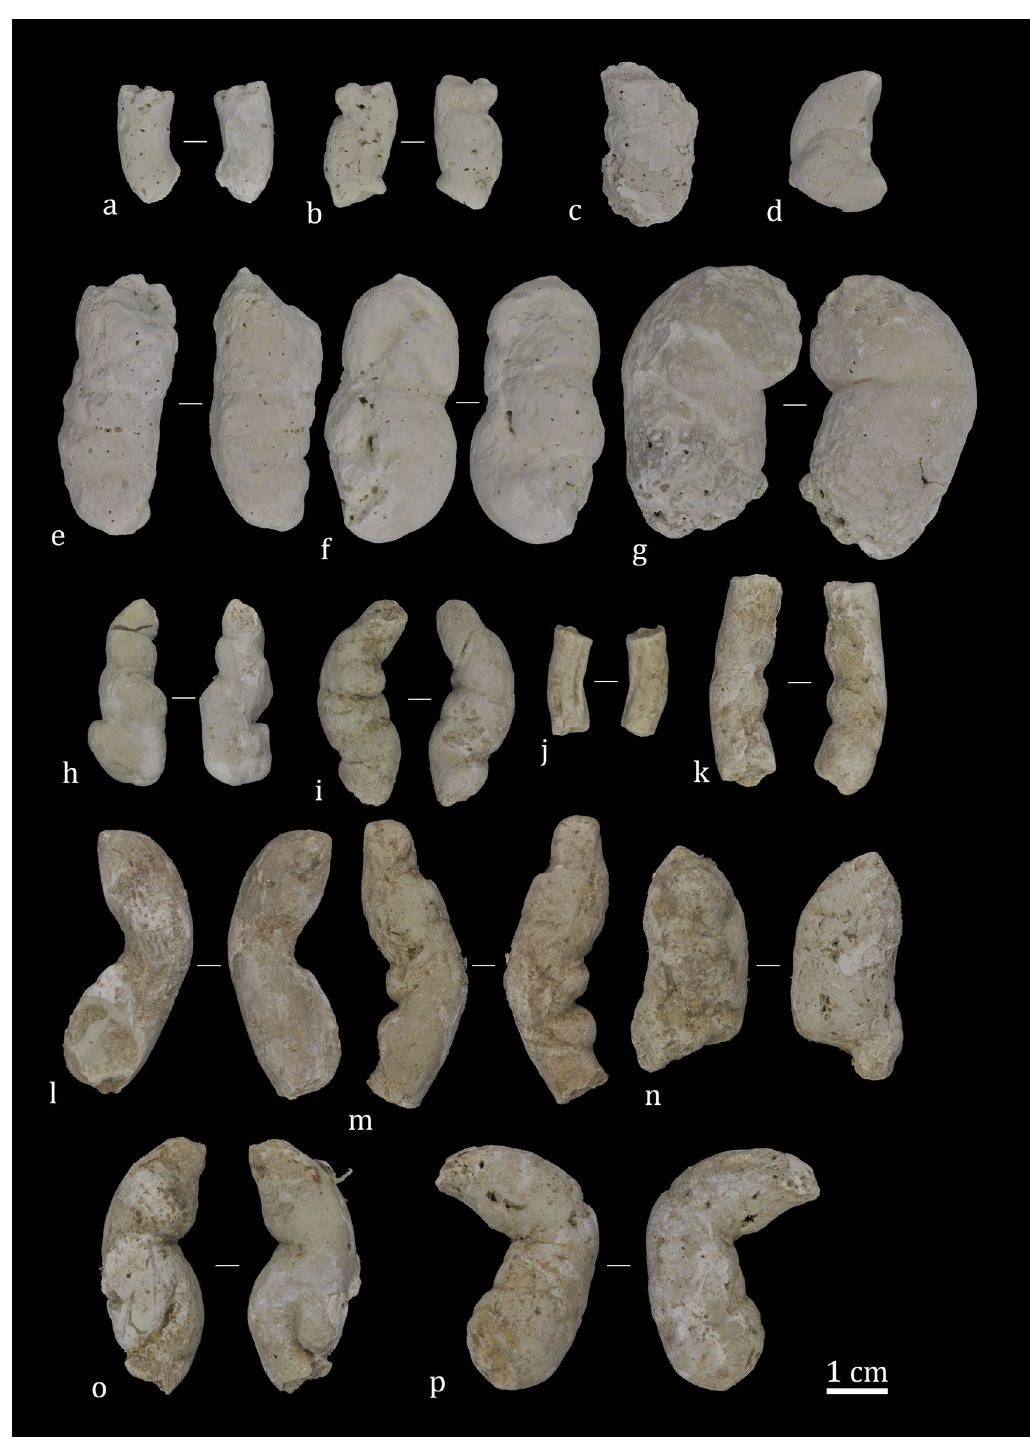
Figure 5. Modern bearded vulture scats. ( a ) to ( g ). Adult scats recovered from nests in the Aragonese Pyrenees (Huesca, Spain). ( h ) to ( p ) Chick (between 40 to 100 days of life) scats from the Breeding Centre for the Lammergeier in Human Isolation (CRIAH) (Zaragoza,